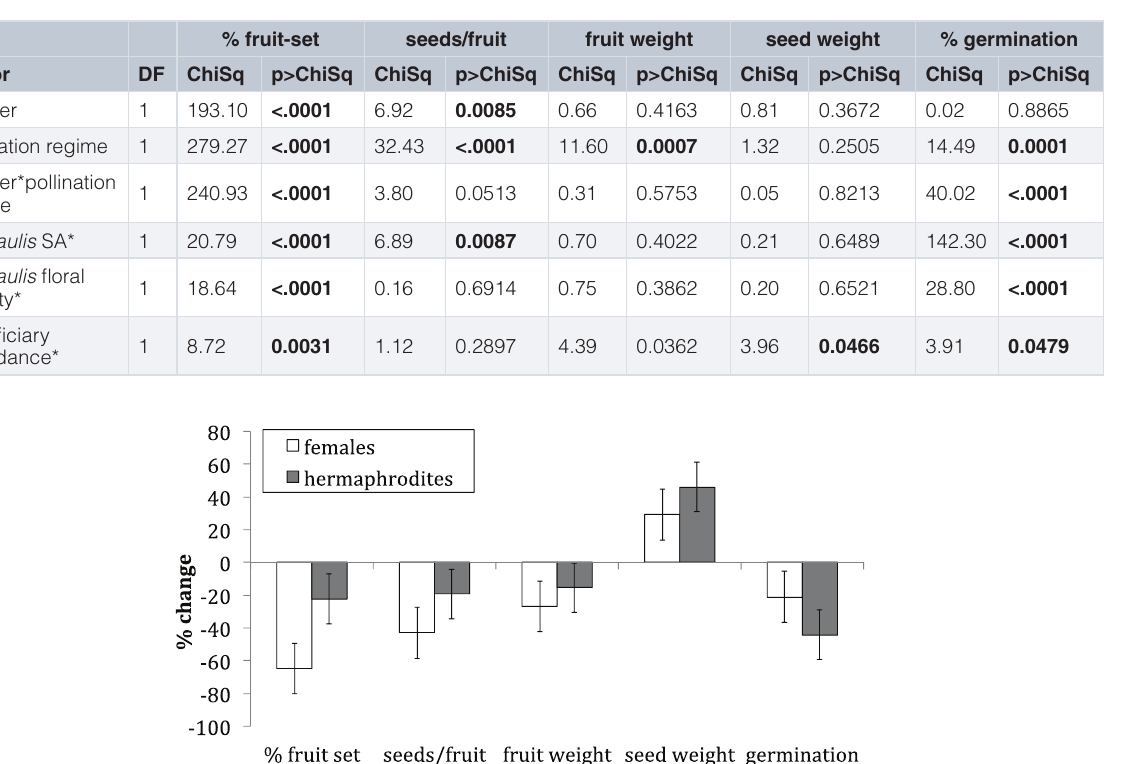
Table 1. Summary of GLM results testing the effect of gender, pollination regime, and the gender by pollination regime interaction on measures of reproductive success with covariate measures of S. acaulis surface area (SA), S. acaulis floral density, and beneficiary abundance indicated by *. Significance is considered at <0.05 and indicated in bold. % fruit-set seeds/fruit